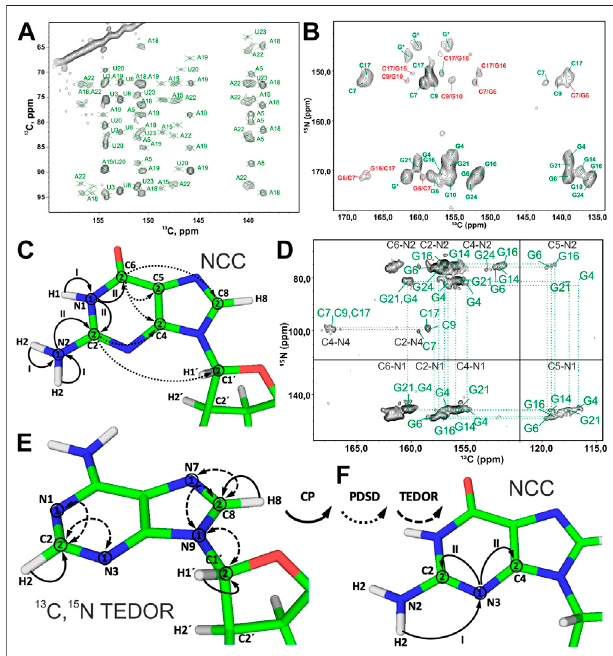
FIGURE6| Nucleobaseassignmentby 13 C-detectedssNMR. (A) Zoom inontheribose – baseregionofthe 13 C, 13 CPARspectrumoftheA,U lab -26mer box C/D RNA acquired at 10 ms PAR mixing time. (B) Zoom in on the base region of the 13 C, 15 N-TEDOR- 13 C, 13 C PDSD spectrum of the G,C lab 26mer box C/D RNA. Intra- and inter-nucleotide correlations are labeled in green and red, respectively. (C,D) NCC experiment for the assignment of nitrogen and carbon resonances in the nucleobases. (C) Magnetization transfer in NCC experiment shown on the example of a guanosine. (D) 2D NCC spectrum of G,C lab 26mer box C/D RNA acquired at 150 ms PDSD mixing time. Magnetization transfer in (E) 13 C, 15 N TEDOR experiment for the assignmentofN7nitrogensinpurinesandN1/N3nitrogensinadenosinesand (F) in the modi fi ed NCC experiment for the assignment of N3 nitrogens in cytidines and guanosines. In magnetization transfer schemes, solid arrows indicate CP transfers, dotted arrows indicate PDSD transfers, and dashed arrows indicate TEDOR transfers; Arabic numbers correspond to spectral dimensions (t 1 – t 2 ); Roman numbers indicate CP transfers. Spectra in fi gures (A,B) and (D) were acquired on a 700 MHz spectrometer at 16 kHz MAS and 13 kHz MAS, respectively. The spectrum in (B) is adapted from (Marchanka et al.,2015).Thespectrum in (D) isadaptedwithpermission from(Marchanka et al., 2013) © John Wiley and Sons,